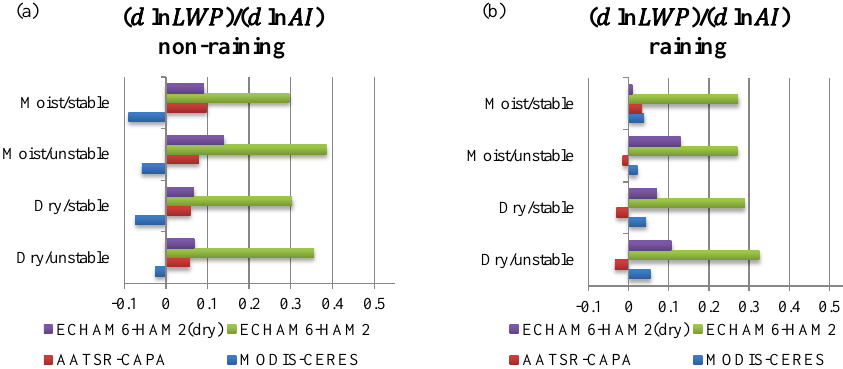
Figure 4. Same as Fig. 3 but for the LWP susceptibility to changes in AI for ECHAM6-HAM2 (E6_Ref), E6_Ref without aerosol